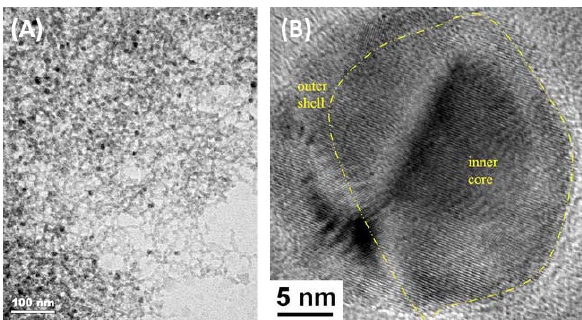
Figure 8. ( A ) TEM image of resorcinol–formaldehyde aerogel ‐ supported Cu core ‐ Cu 2 O shell